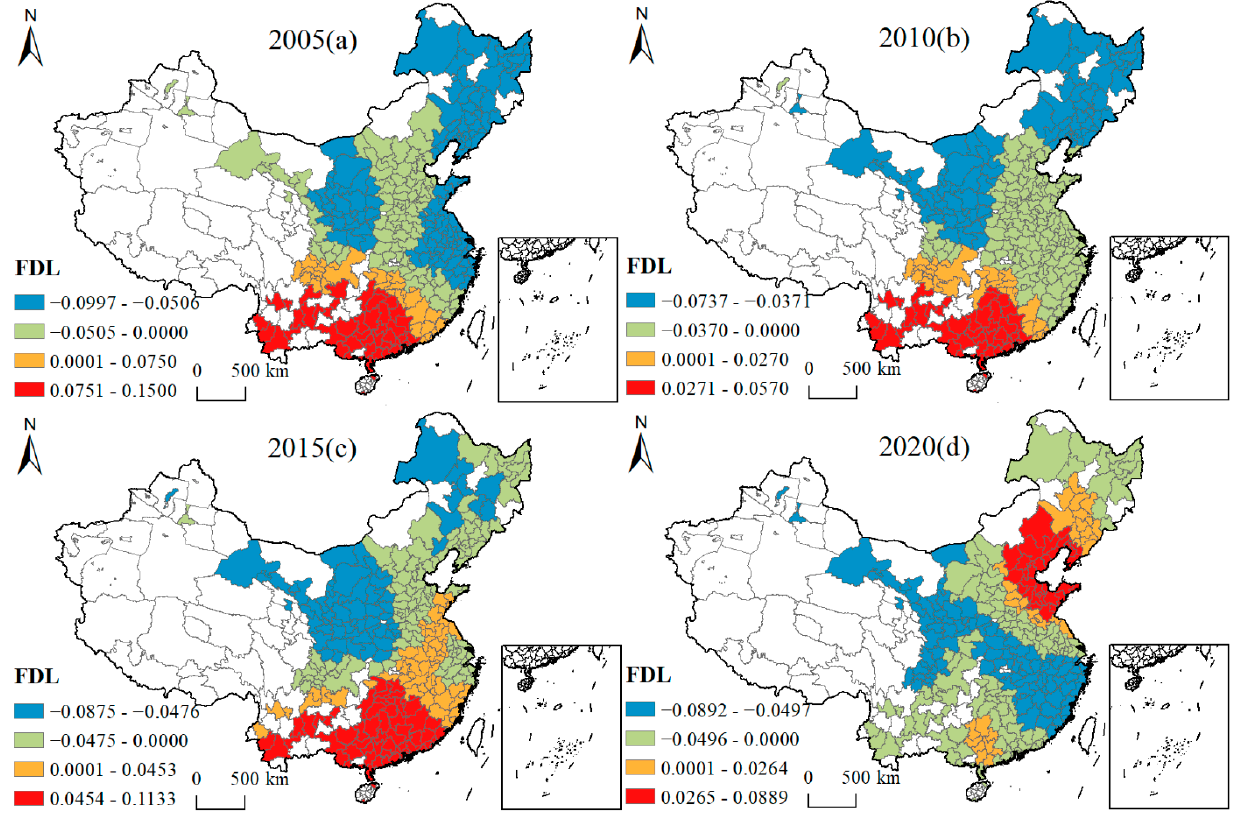
Figure 10. Four-year regression coefficients of FDL.